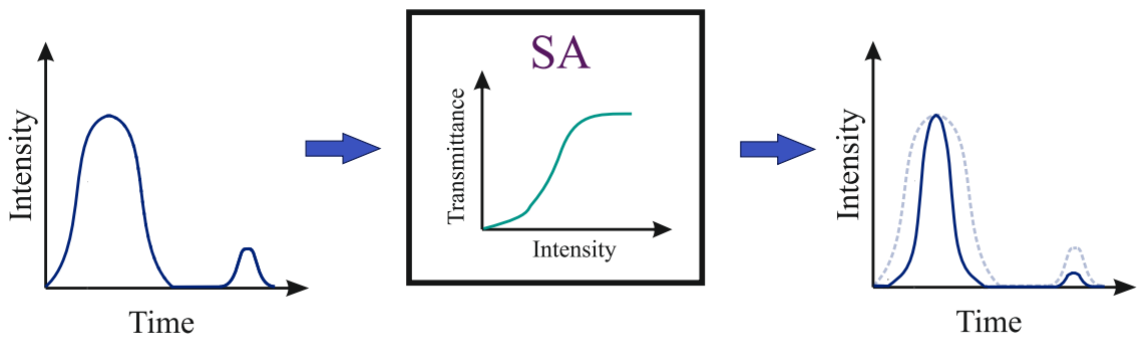
Figure 9. The processes of cutting the leading and trailing edges (left pulse) and smoothing fluctuation pulses of low intensity (right pulse).